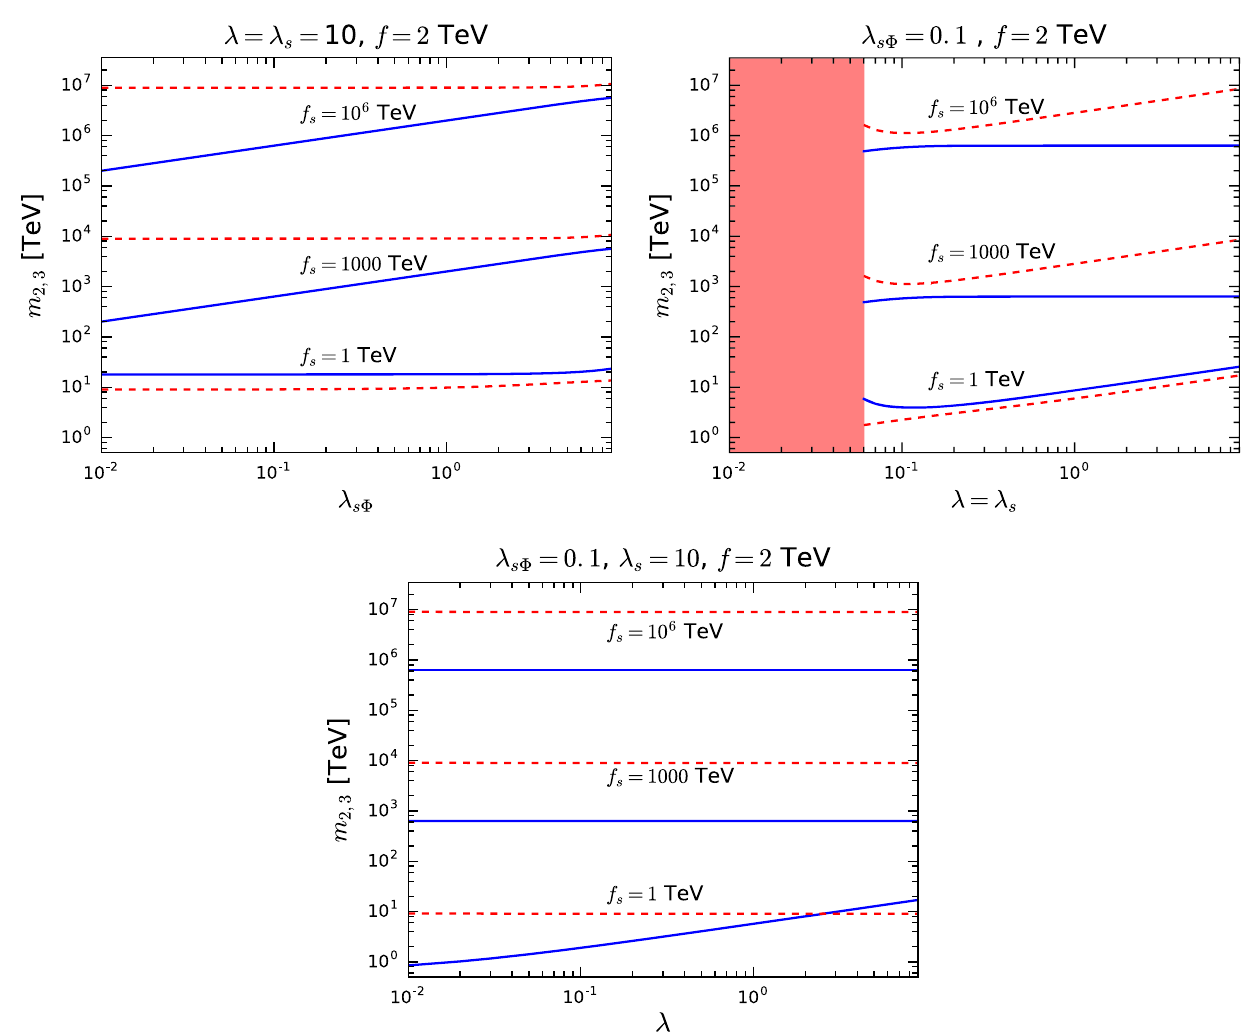
Fig. 2 The profiles of the scalar masses m 2 and m 3 as a func- tion of λ s φ (upper left), λ = λ s (upper right), and λ (lower). The other parameters are chosen at fixed values: f = 2 TeV; f s = 1 TeV , 10 3 TeV , 10 6 TeV; λ = λ s = 10 (upperleft); λ s φ = 0 . 1(upper right); λ s = 10 and λ s φ = 0 . 1 (lower). The red-dashed line represents